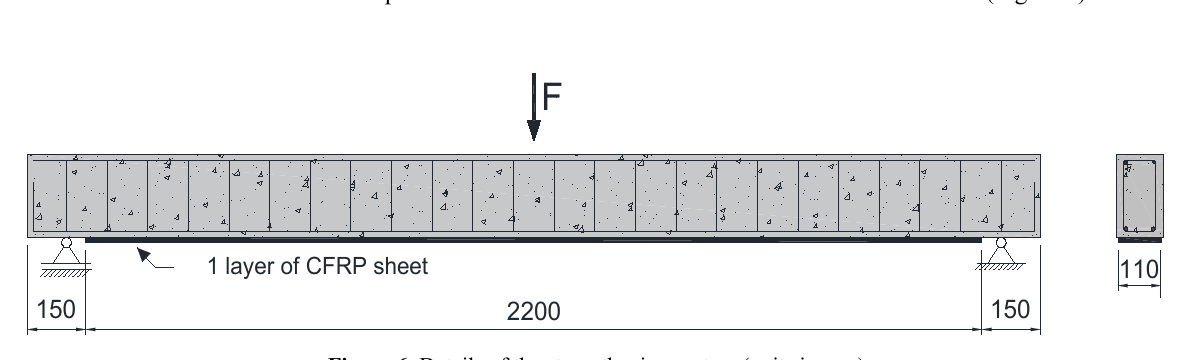
Figure 6. Details of the strengthening system (units in